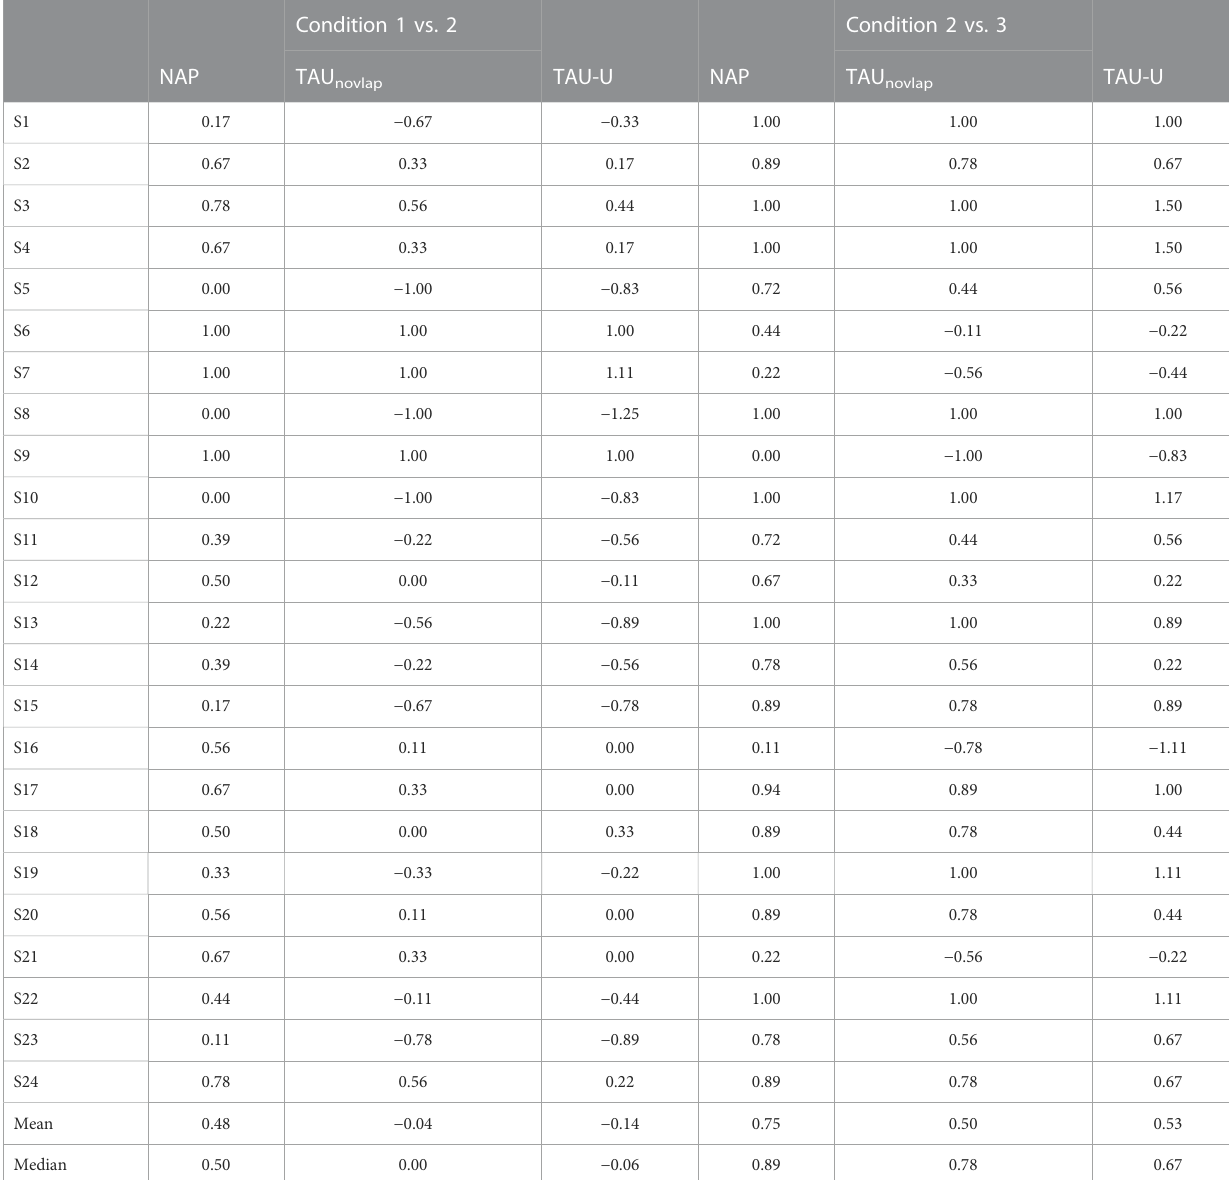
TABLE3Effectsizevalues(NAP,TAU novlap ,andTAU-U)byparticipantsforthetransitionfromCondition1(nointervention)toCondition 2(standardteaching)and the transition from Condition 2 to Condition 3 (robot intervention). Condition 1 vs.